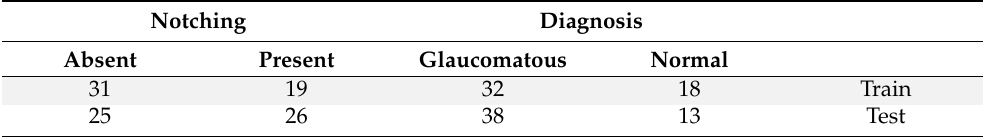
Table 7. Optical disc segmentation results—adapted from [39].